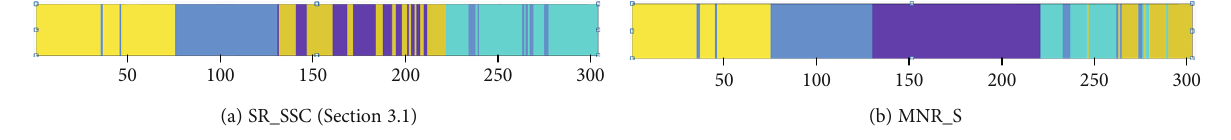
Figure 7: Clustering result of ‘ dance+walking+shark+yoga+stretch. ’ . Table 2: Accuracy ( R ) of fi ve algorithms in the 15 datasets synthesised. ð a Þ Dataset